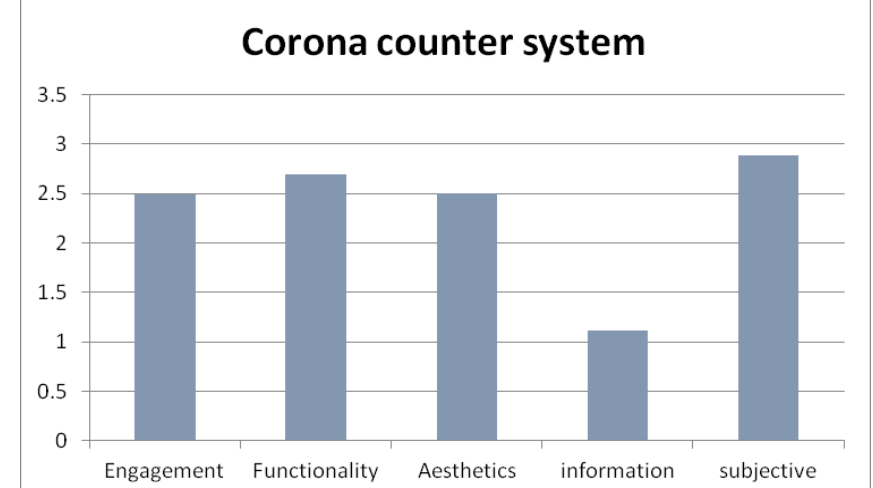
Fig 8. The evaluation of indicators in Corona counter system according to MARS